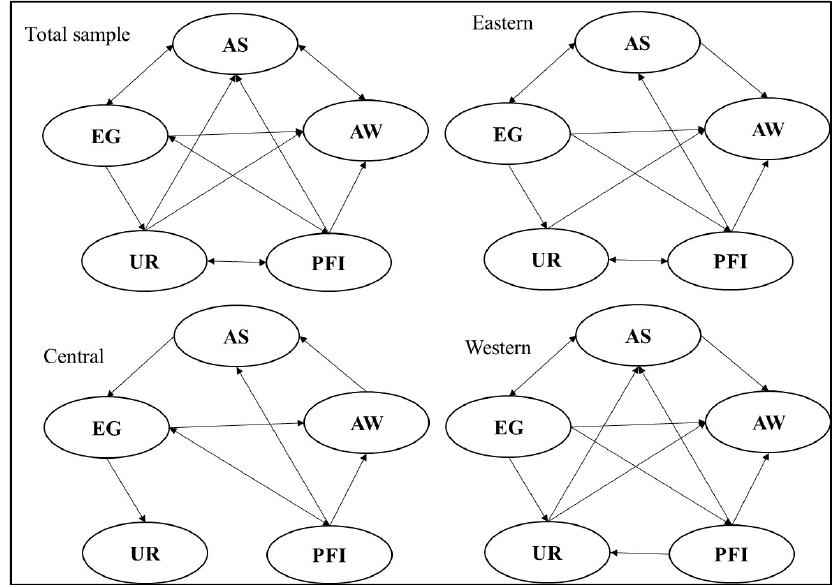
Figure 1. Granger causality relationship flows.